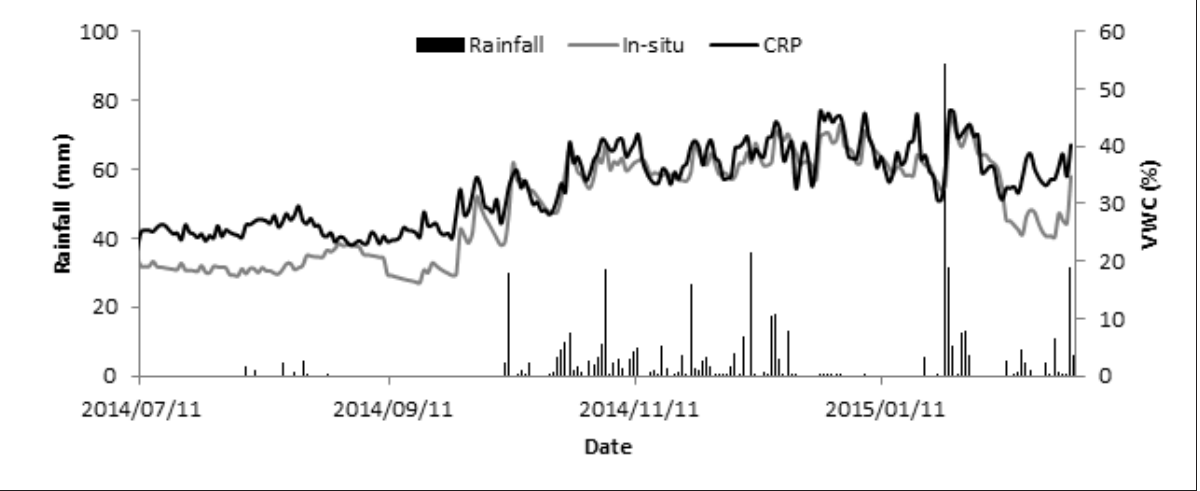
Figure 6: Daily soil moisture estimates for Catchment VI using in-situ and cosmic ray probe (CRP) methods plotted against